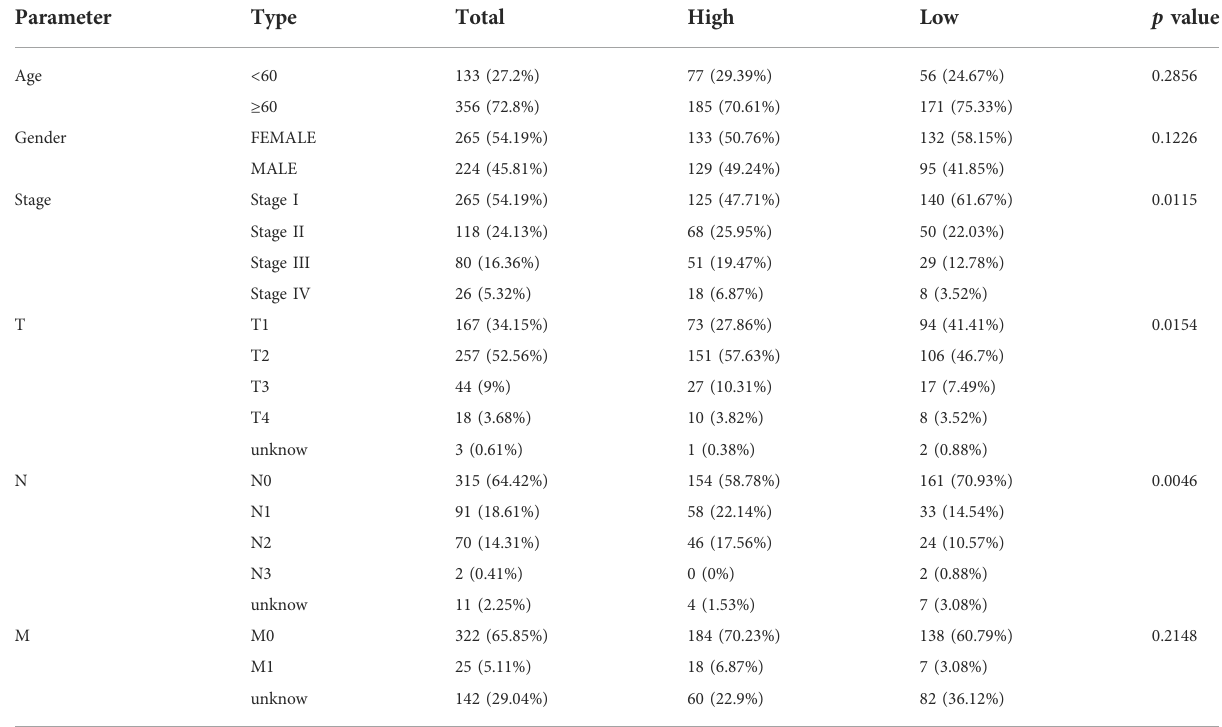
TABLE 3 comparison of clinical features between two-risk groups in entire set. (Chi-squared